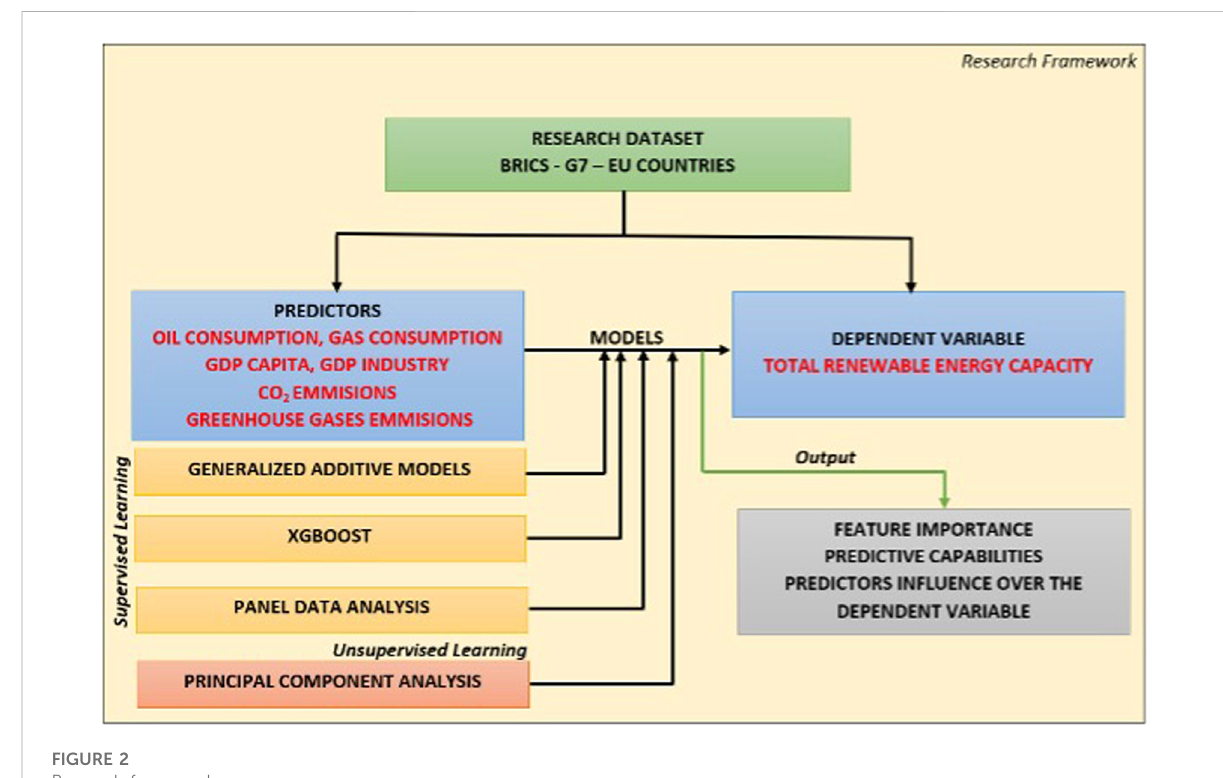
FIGURE 2 Research